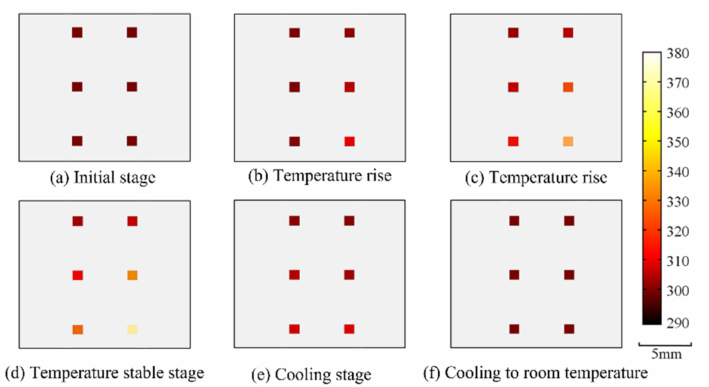
Figure 7. 2-D Temperature distribution of multi-chip power LED in different stages ( a – f ). The temperature of the substrate with no magnetic nanoparticle cannot be